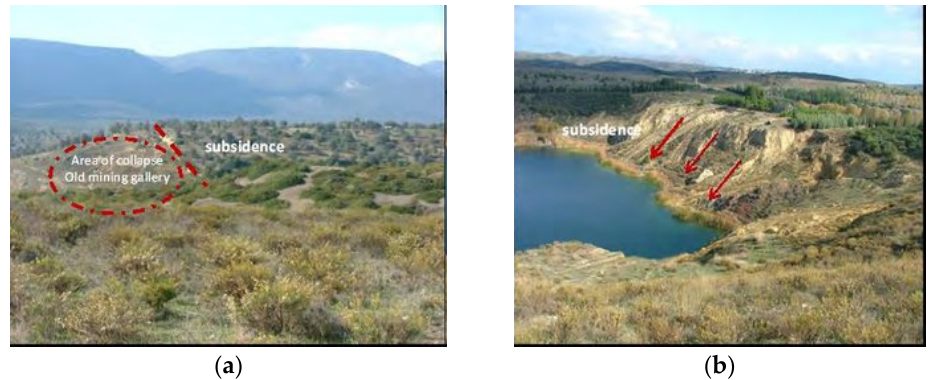
Figure 5. Aliveri pit lake: ( a ) SW lake’s slope, where failures were observed and ( b ) west area where subsidence is depicted [11].